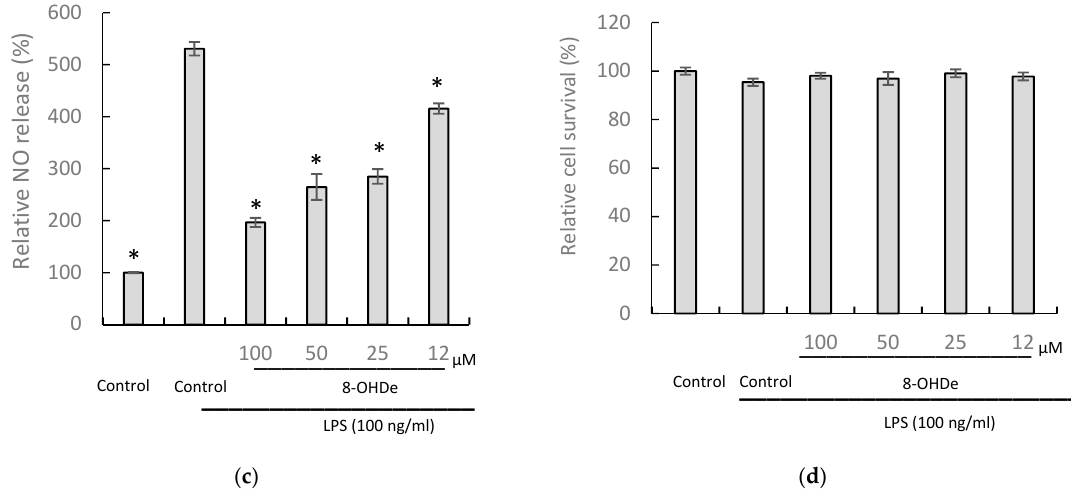
Figure 6. Effects of 8-OHDe-7- α -glucoside ( a , b ) and 8-OHDe ( c , d ) on the inhibition of LPS-induced NO production ( a , c ) and cell survival ( b , d ) in murine macrophage RAW264.7 cells. Cells were incubated with the indicated concentrations of isoflavone for 1 h before treatment with LPS (100 ng / mL) for 24 h. The amounts of NO were determined using the Griess reagent in the culture medium. Cell viability was determined with MTT assay. Each value indicates the mean ± standard deviation (SD), and is representative of the results obtained from four independent experiments. * ( p < 0.001) is statistically significantly different from the value for the cells treated with LPS treatment alone.